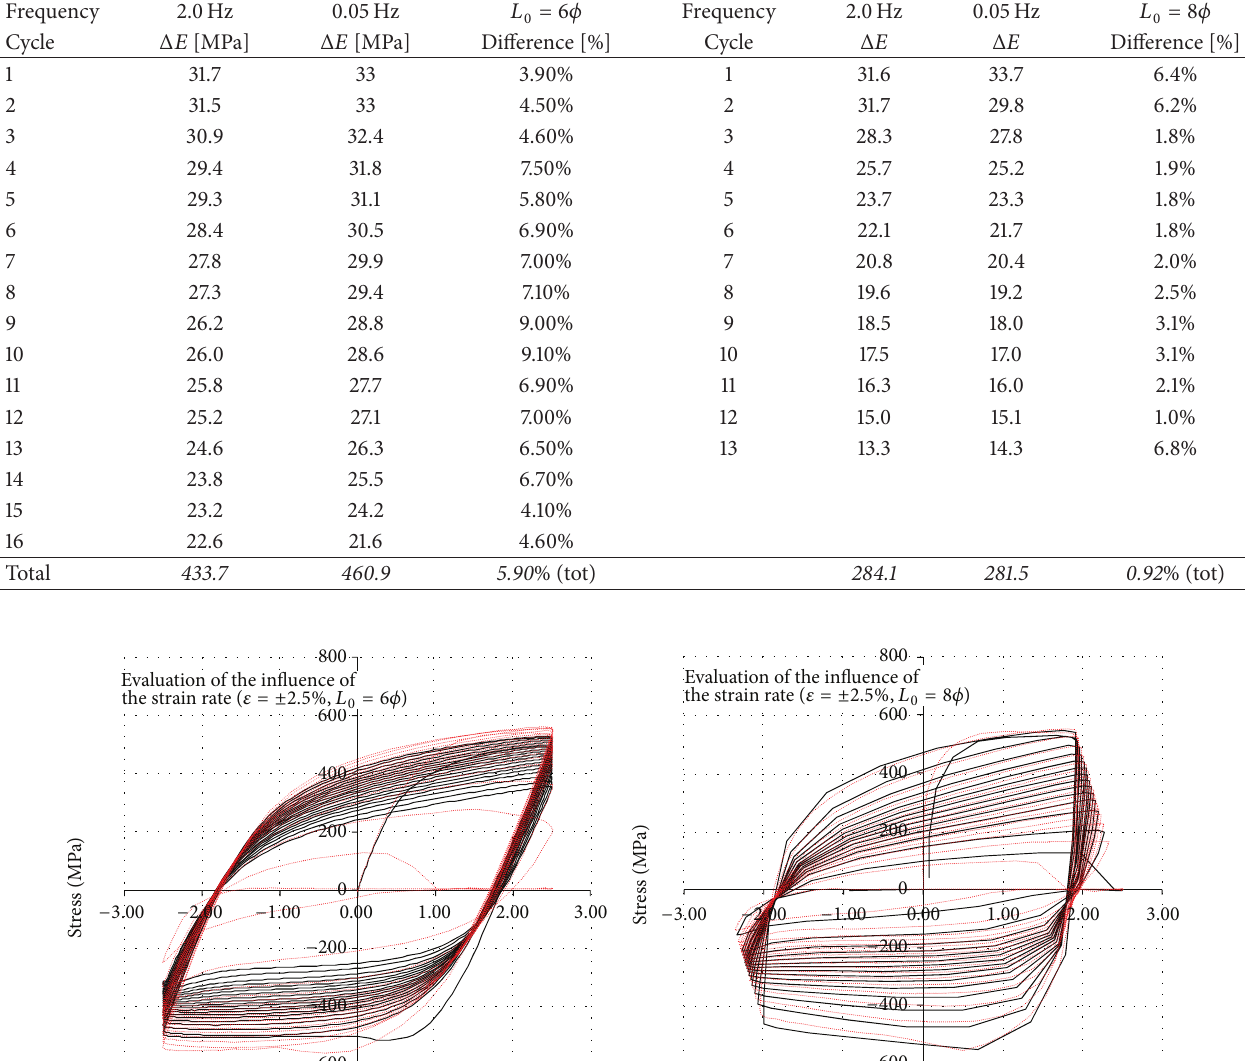
Table 2: Experimental results of LCF tests for different testing frequency and percentage differences.